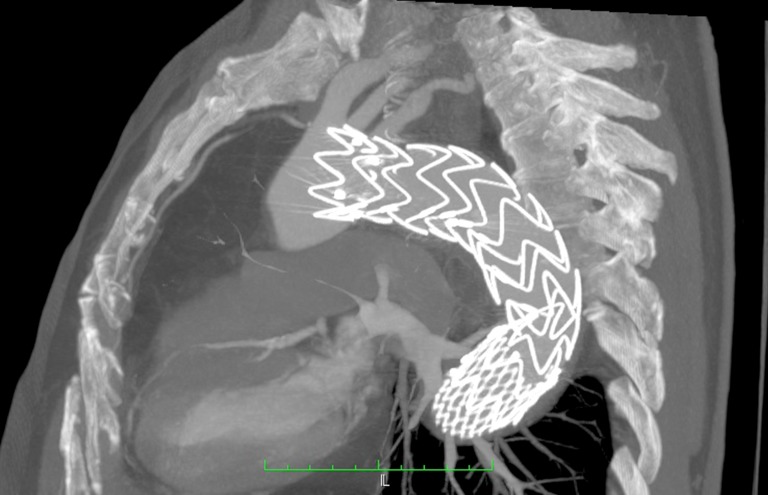
Intraoperative image during repair of the proximal flap with a stent graft.